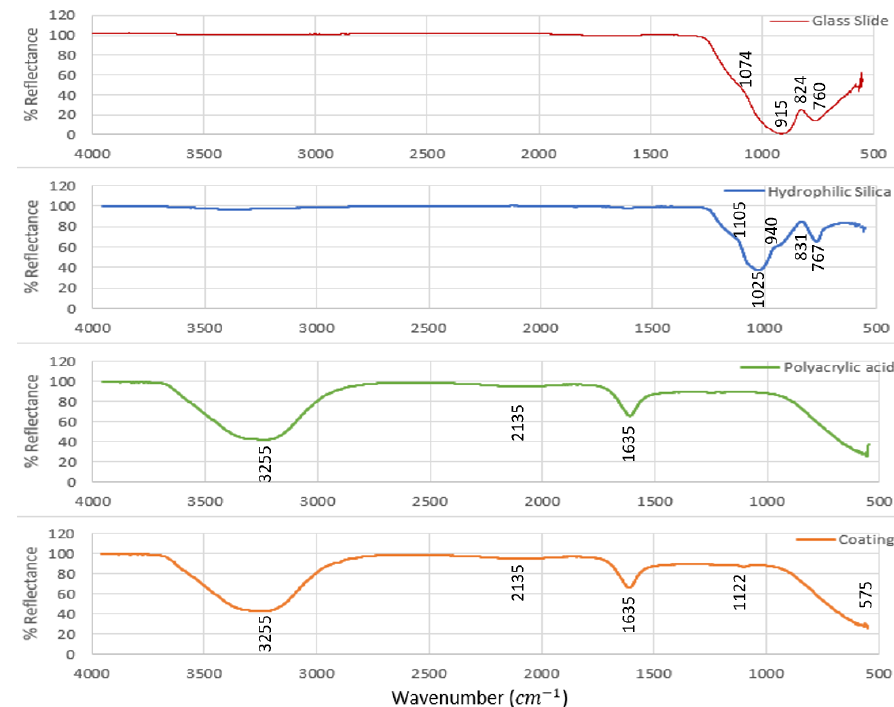
Figure 3. FTIR spectra of the glass slide, hydrophilic silica, polyacrylic acid and coating with particle loading 95 vol.